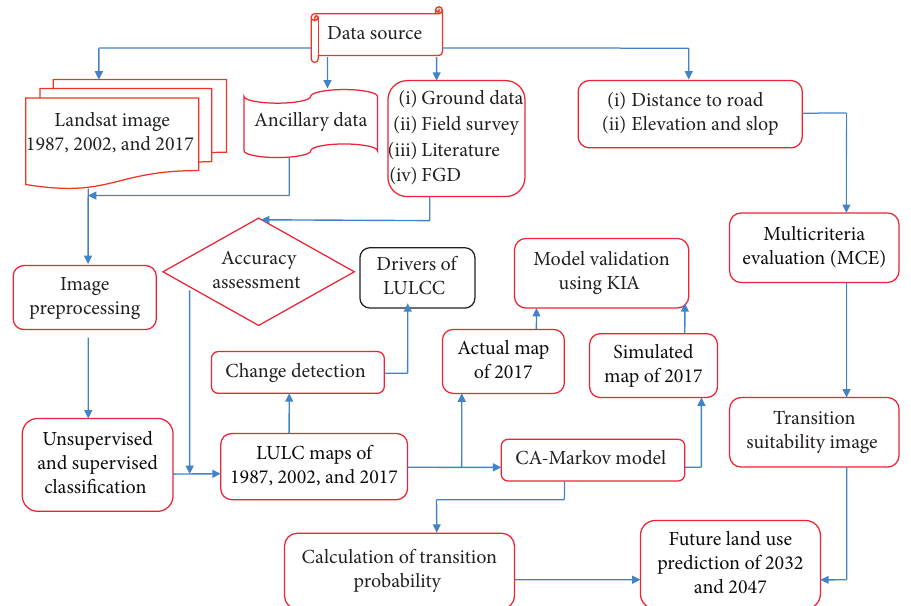
Figure 4: A schematic representation of the study adopted from Yirsawet al.